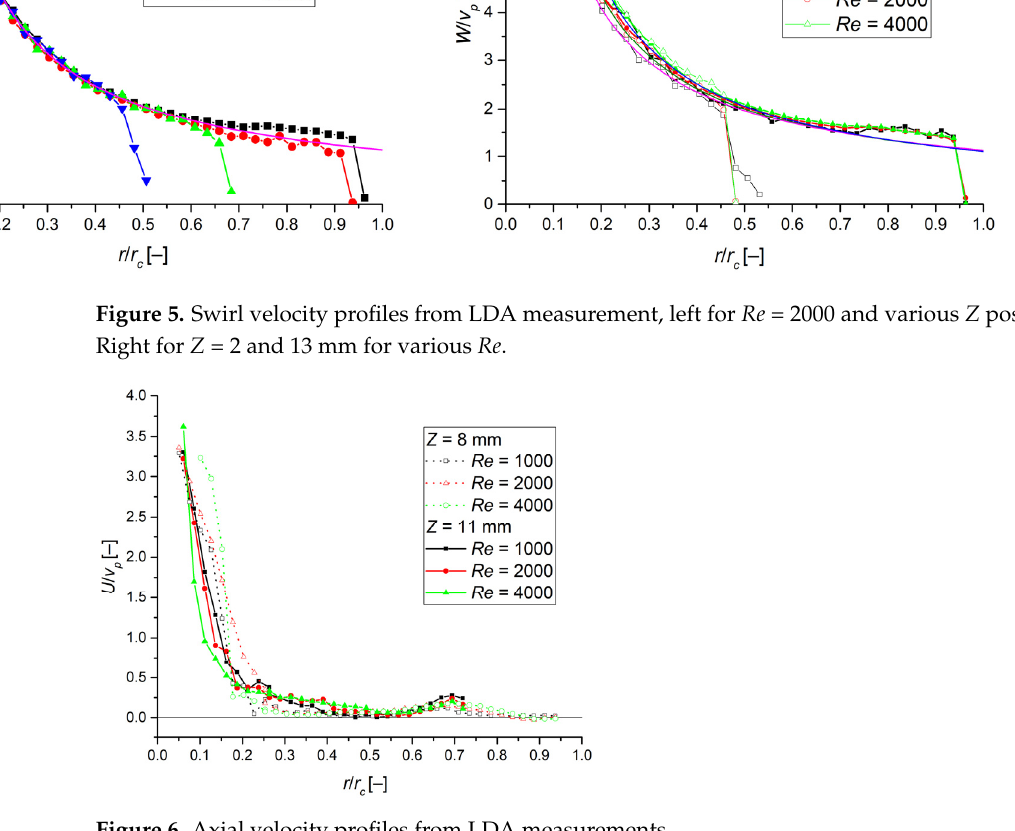
Figure 6. Axial velocity profiles from LDA measurements.